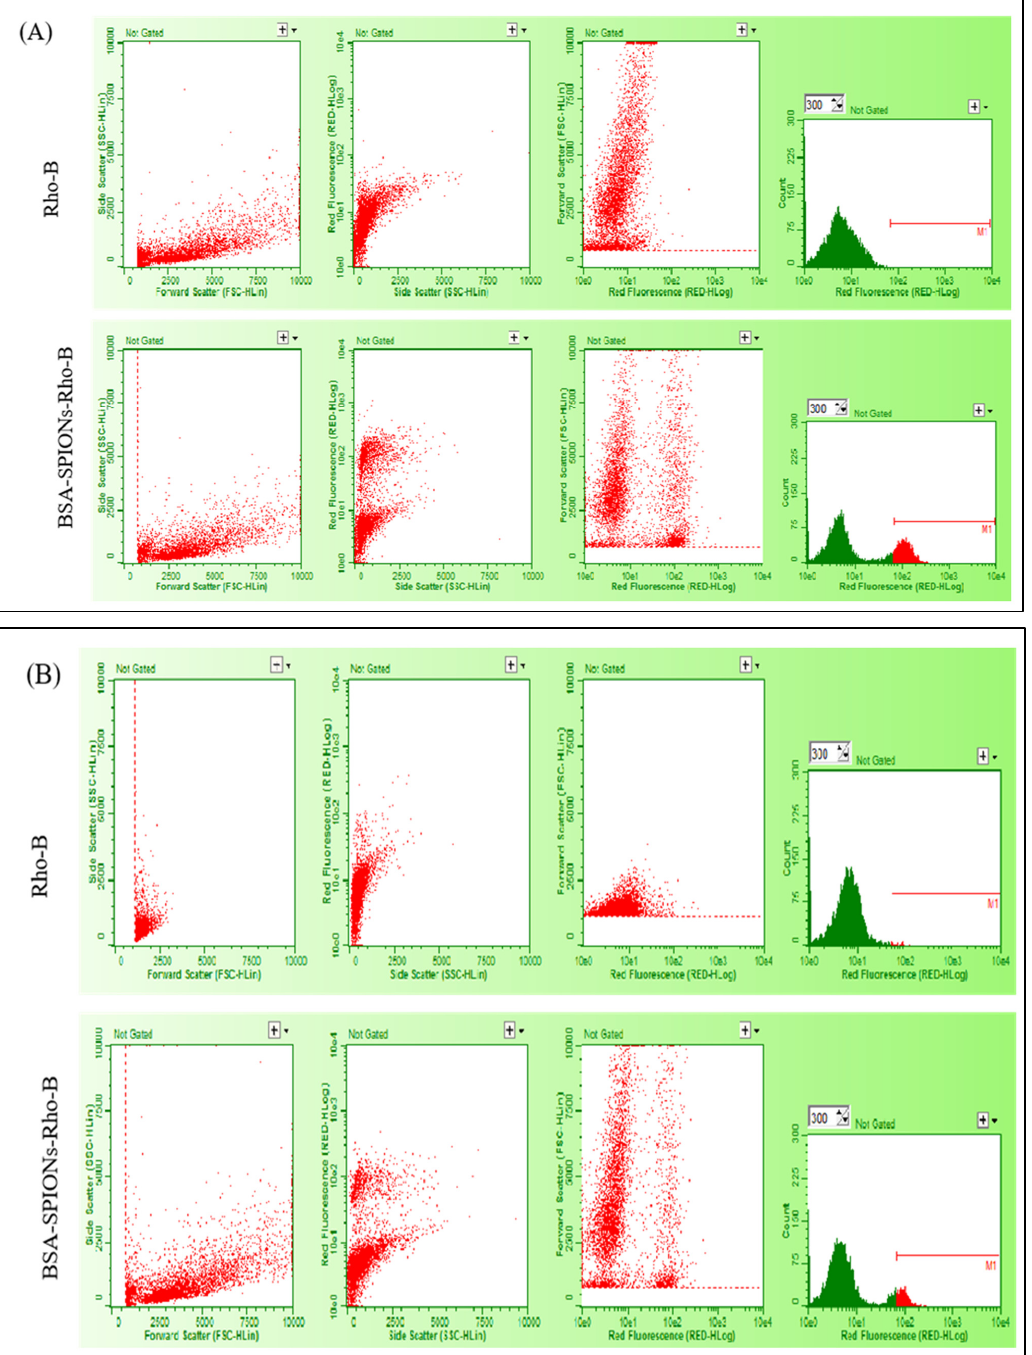
Figure 8. Cellular uptake profiles of Rho-B and BSA-SPIONs-Rho-B from different cells: ( A ) MCF-7 cells, and ( B ) T47D cells, showing side scatter v/s forward scatter, fluorescence v/s side scatter, forward scatter v/s fluorescence, and fluorescence histogram (log).